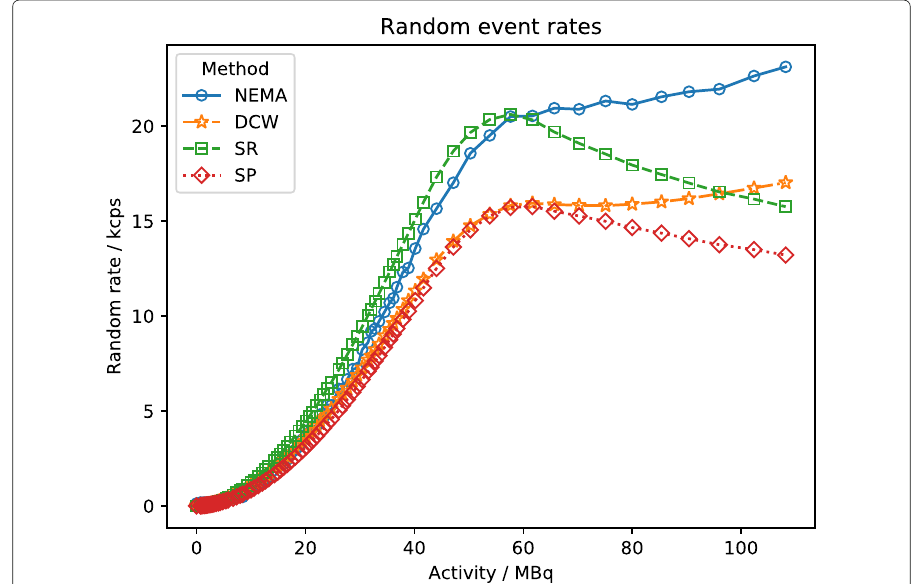
Fig. 5 Comparison of different methods for the determination of random event rates. NEMA means a method based on the NEMA standard using Eq. 1, DCW uses a delayed coincidence window, SR is based on the singles rate using Eq. 4, and SP incorporates additional corrections using Eq.